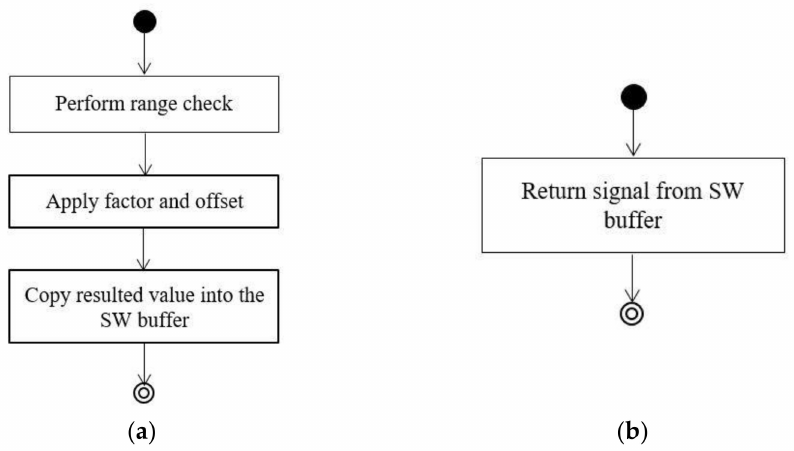
Figure 7. ( a ) Setting the signal to software buffer. ( b ) Getting the signal from software